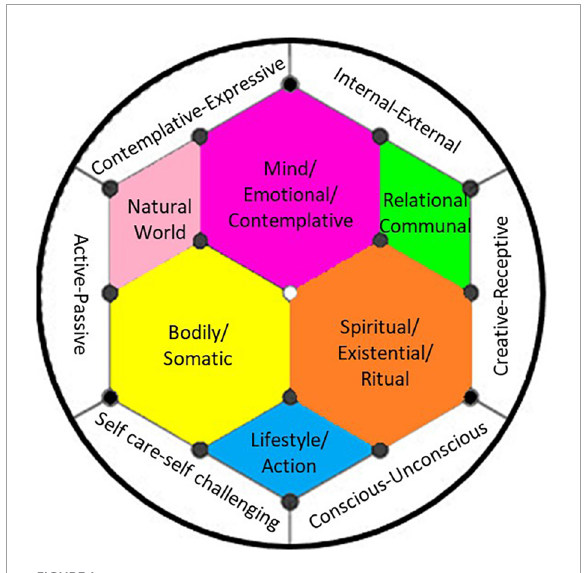
FIGURE1 Synthesized model of integration: The hexagon reflects six interconnected domains of existence, with the more personal ones toward the center. The outer ring reflects continuums on which integration activities can be placed. The goal is a balance of integration activities addressing all domains of